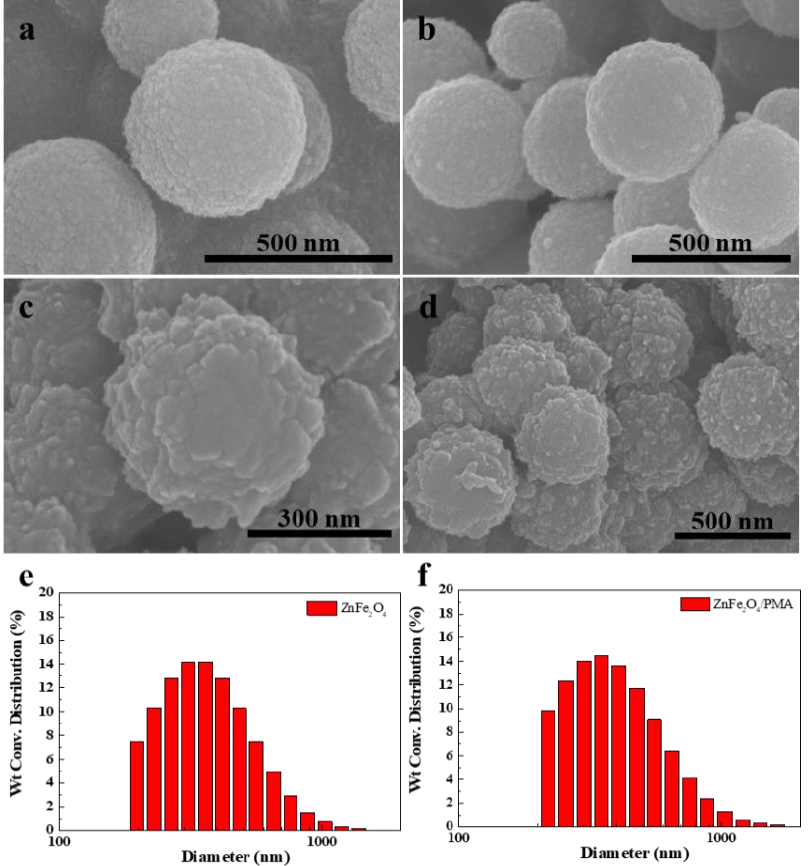
Figure 1. SEM and size distribution of ZnFe 2 O 4 ( a , b , e ) and ZnFe 2 O 4 /PMA ( c , d , f ) core-shell particles. Figure 2a,b presents the TEM images of ZnFe 2 O 4 . The size of pure ZnFe 2 O 4 was about 300 nm. Figure 2c,d indicates the shell PMA. The dark spherical state inside the particle is the ZnFe 2 O 4 portion. The gray area in Figure 2c covers the dark core ZnFe 2 O 4 with a PMA shell coated on the core. The PMA thickness was approximately 20 nm, as shown in Figure 2d. TEM images of zinc ferrite and ZnFe 2 O 4 /PMA particles clearly show the outer PMA shell surrounding the ZnFe 2 O 4 core. Compared with the SEM images in Figure 1, the surface features in Figure 2 look different due to the difference in measurement method and